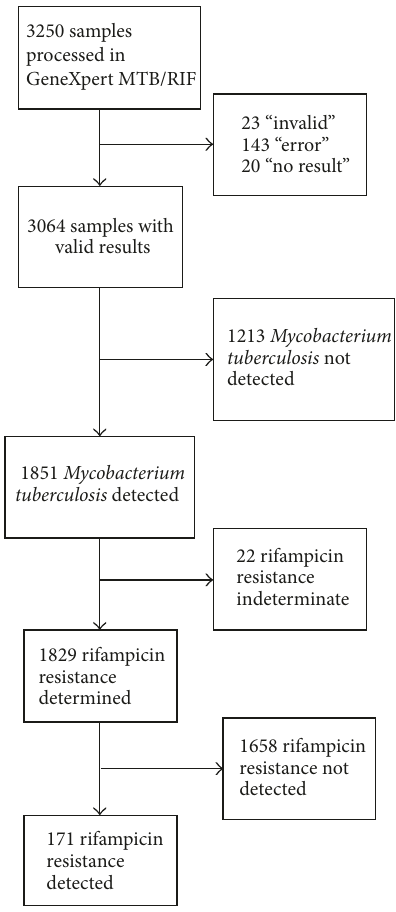
Figure 1: Flowchart of sample results using the GeneXpert MTB/RIF